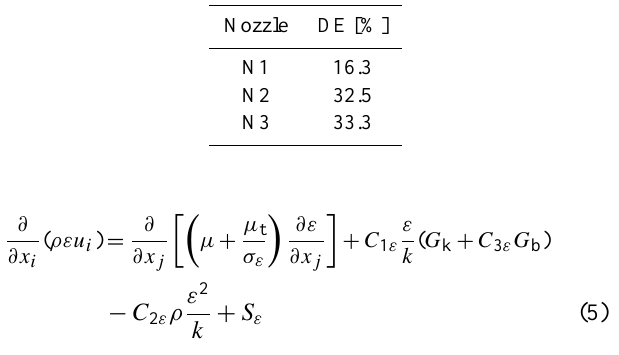
Table 2. Comparison of deposition